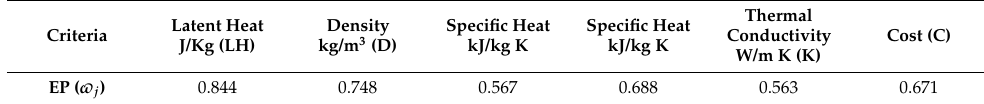
Table 2. The equilibrium points (EP) in the IVEP method application